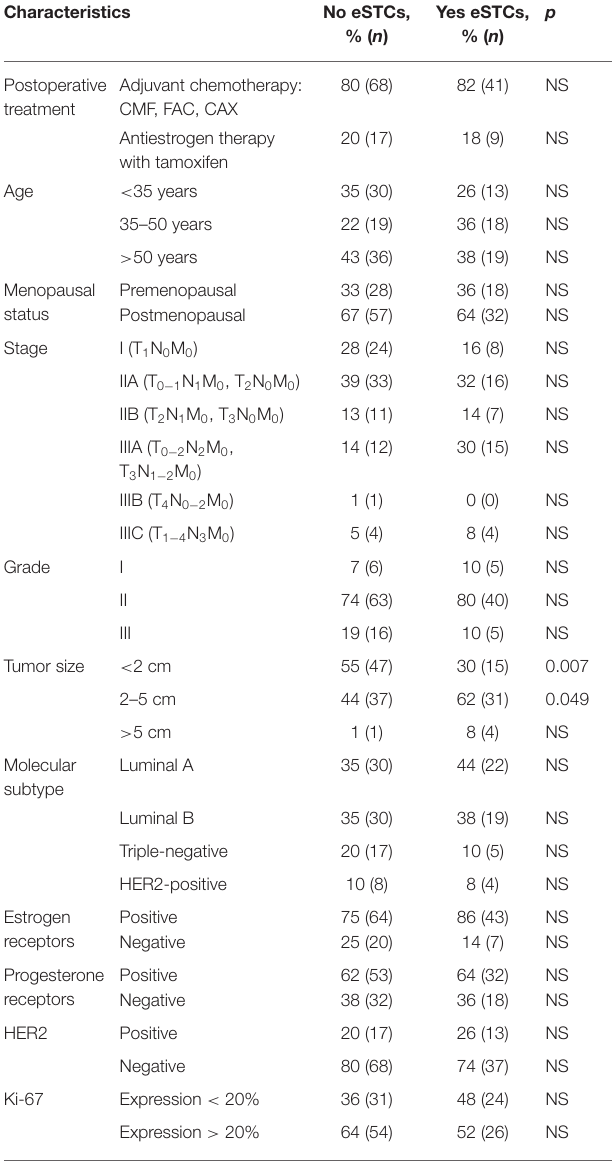
TABLE 1 | Clinicopathological characteristics of breast cancer patients.